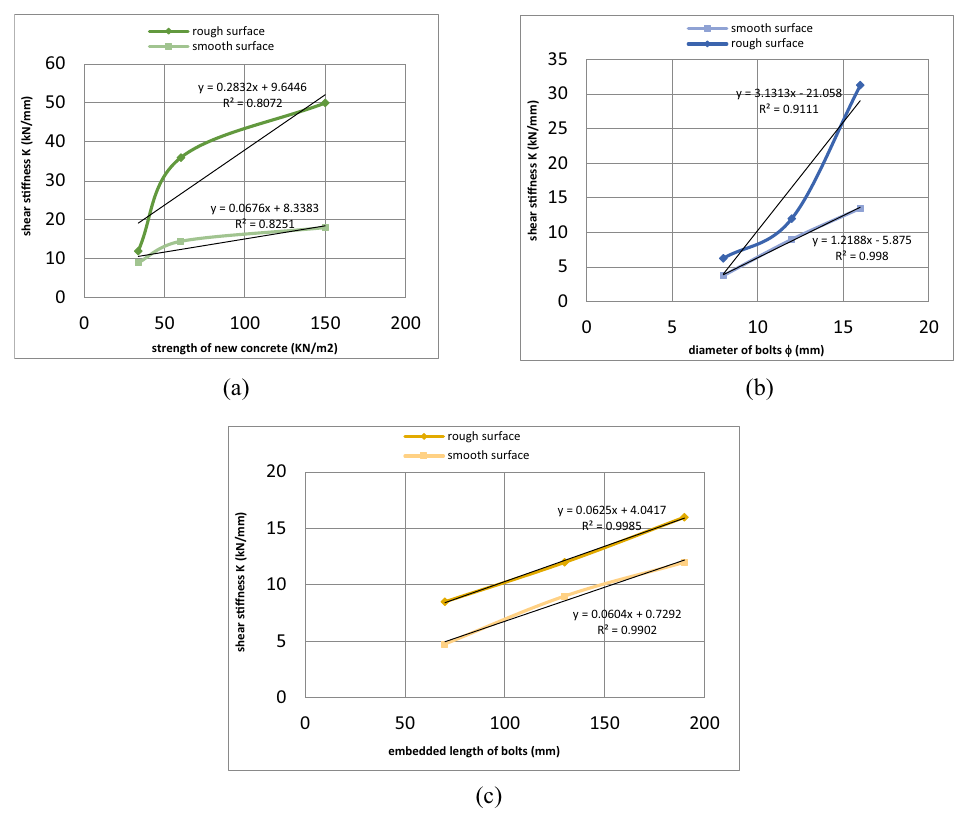
Figure 8: Relationship between shear sti ff ness and a variables ( a ) diameter ∅ ( mm ) , ( b ) strength of new concrete ( kN/m 2 ) , and ( c ) embedded length of bolts ( mm )